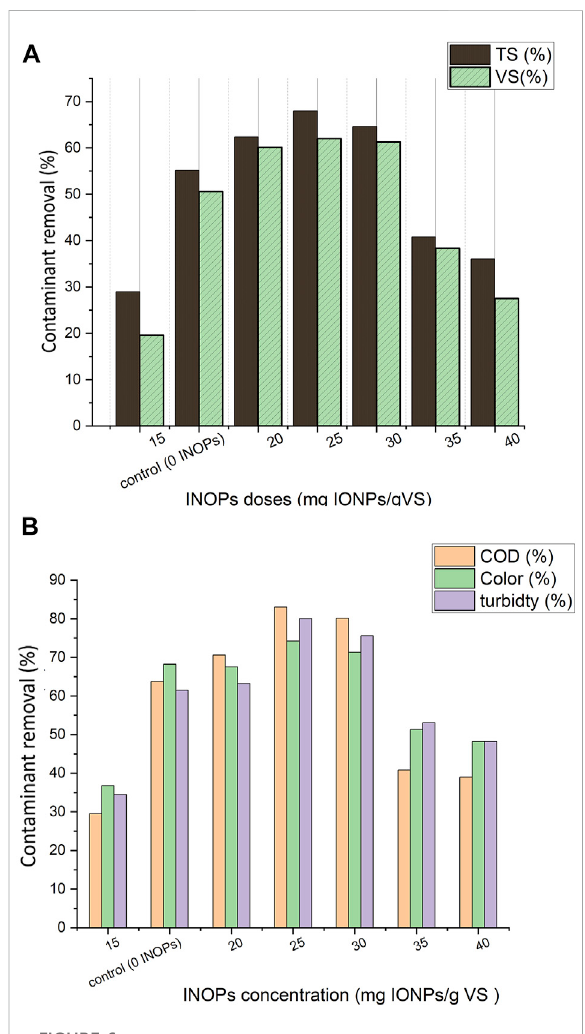
FIGURE 6 EffectofIONPson (A) -TSandVS.removal ef fi ciencyand (B) - TCOD, color, and turbidity removal ef fi